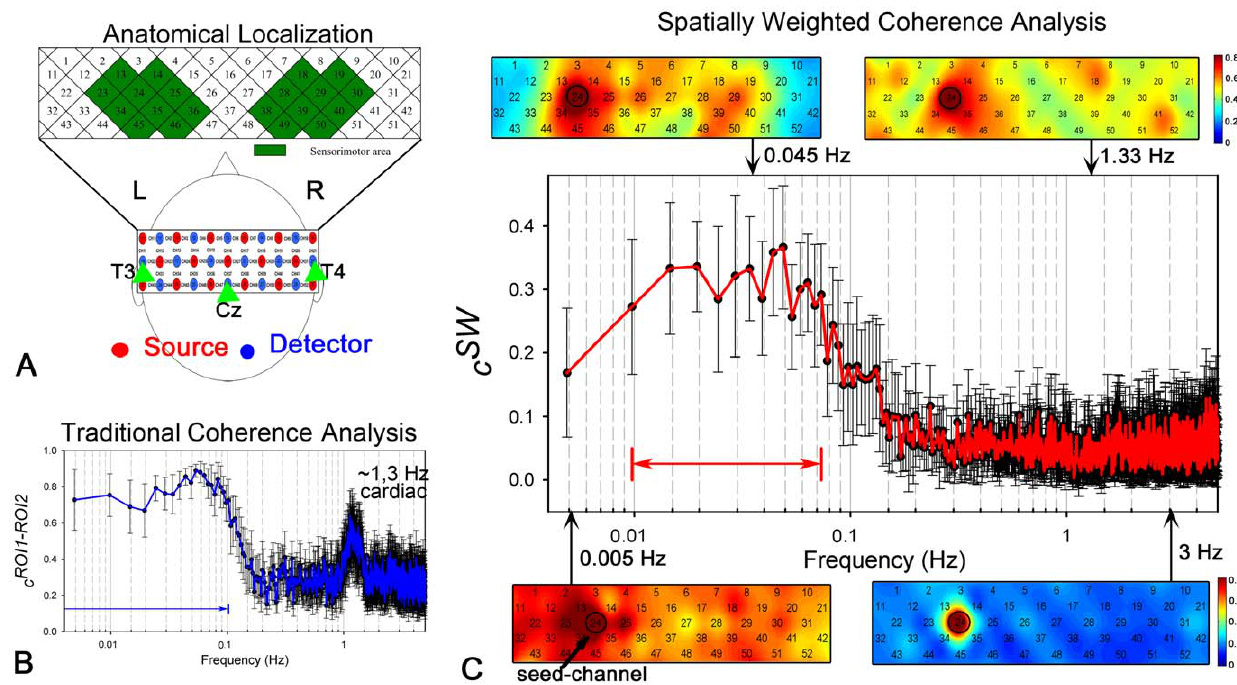
Figure 6. Comparison between the proposed and traditional methods on the real resting-state fNIRS dataset. (A) Schematics of the fNIRS probe array and the anatomical localizations of the fNIRS channels. The labeling maps with green indicate the channels covering the sensorimotor area. (B) The coherence curve of the bilateral sensorimotor areas across all the subjects derived from the traditional method. The error . (C) The group results of the proposed bar indicates the standard error. The horizontal blue arrow at the bottom indicates the estimated RSFC tr df method with four typical frequency-specific connectivity maps. The error bar indicates the standard error across subjects, and the horizontal red . arrow indicates the estimated RSFC sw df